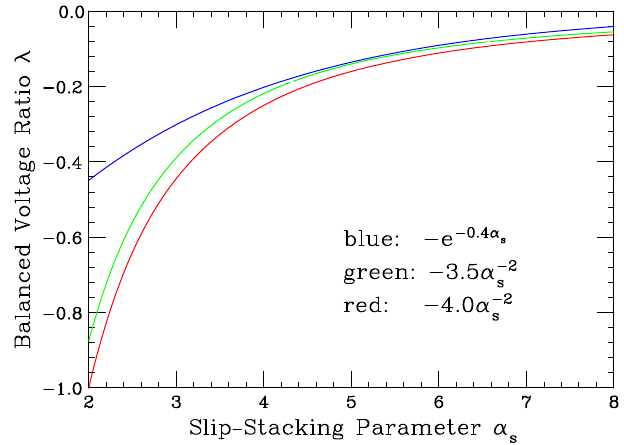
FIG. 1. Comparison of derived compensation second-harmonic ratio λ with empirical values obtained by Eldred through simulations. Our determination is shown in